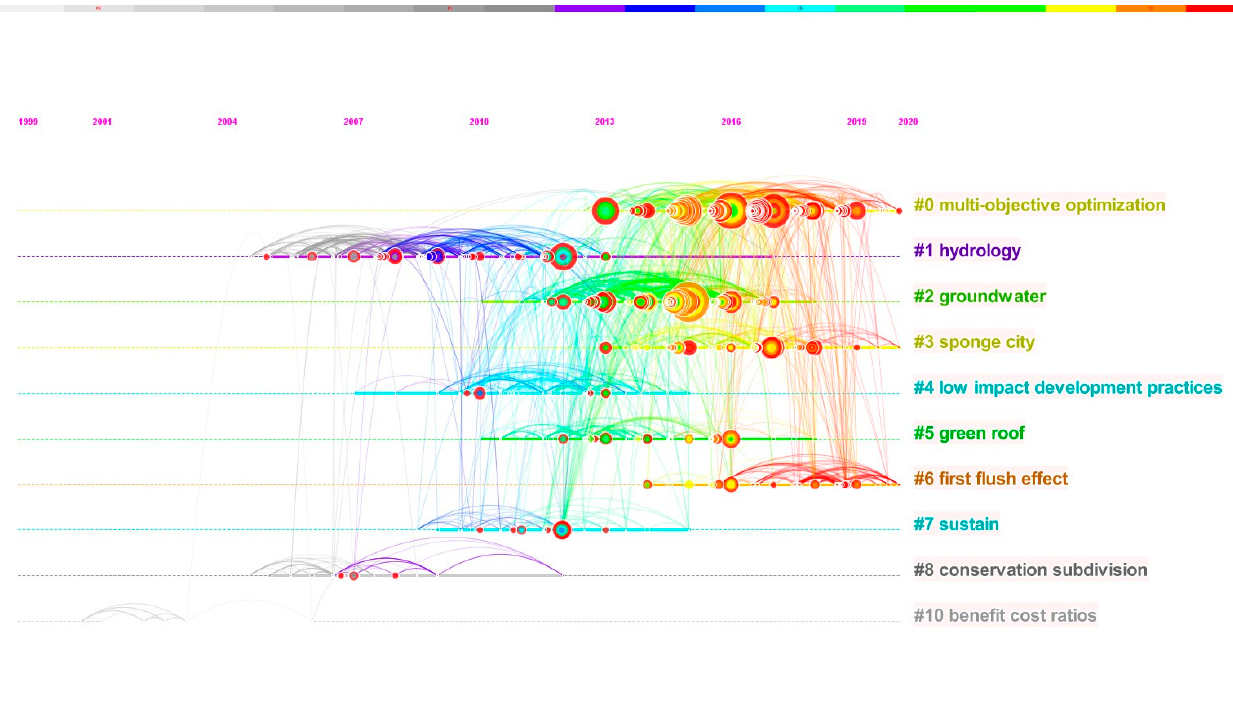
Figure 4. The time-line view of the LID framework research based on the WOS. Table 6. The co-citation clustering of the LID research according to the WOS.